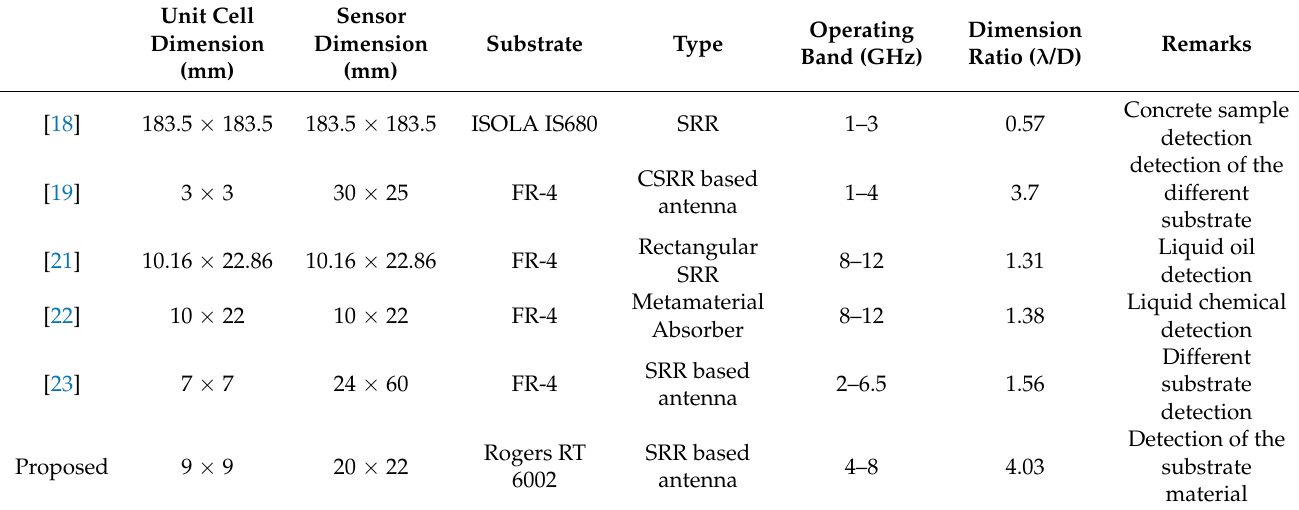
Table 3. Comparative analysis with other established